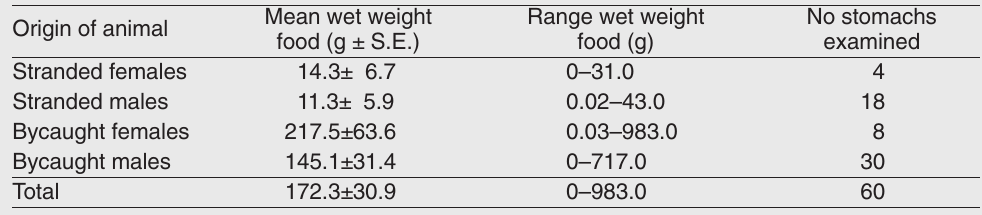
Table 6. Quantities of food remains found in harbour porpoise stomachs in Danish waters, both North Sea and Inner Danish, 1996-98, by actual observed wet